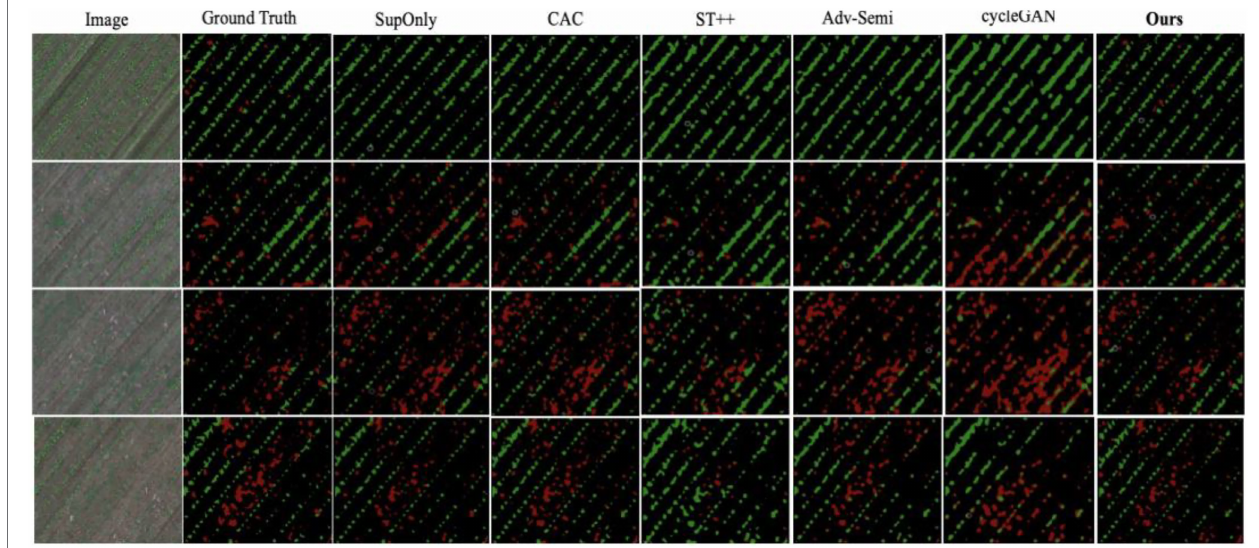
FIGURE 7 | Visual comparison between our method with state-of-the-art methods and SupOnly.